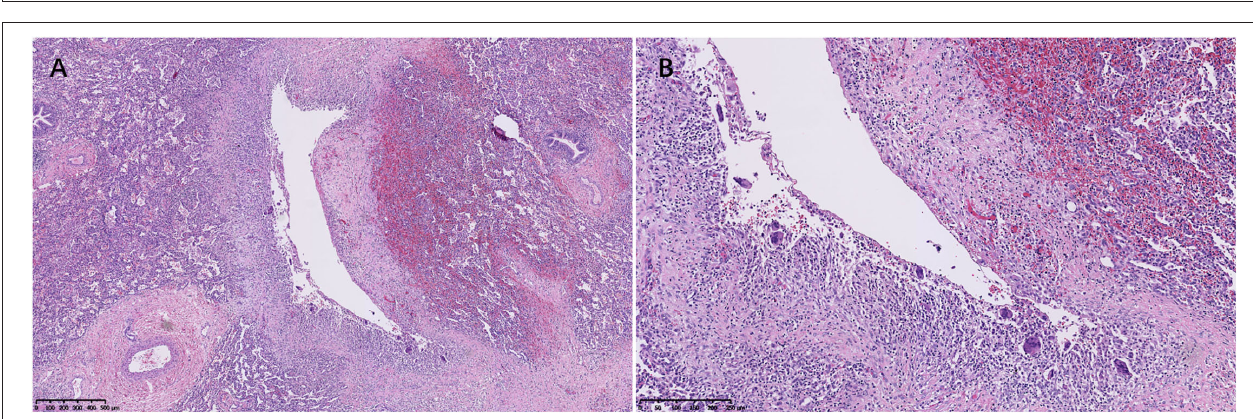
FIGURE 3 | An air cyst was around the bronchovascular bundles (A) , and the cystic walls consisted of connective tissue lined with uninucleated and multinucleated macrophages (B) (Case 3).